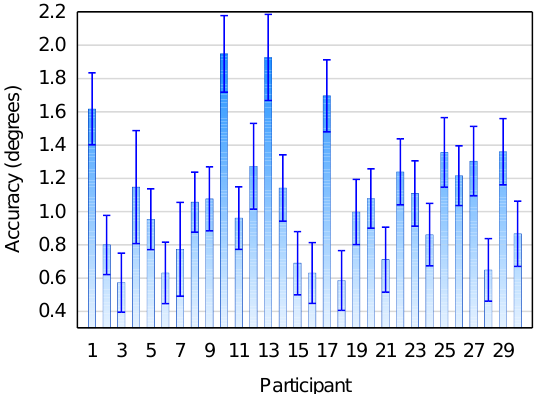
Figure 5: Average accuracy per participant at 100 Hz in the centre of the head box. Vertical bars denote 95% confidence intervals.